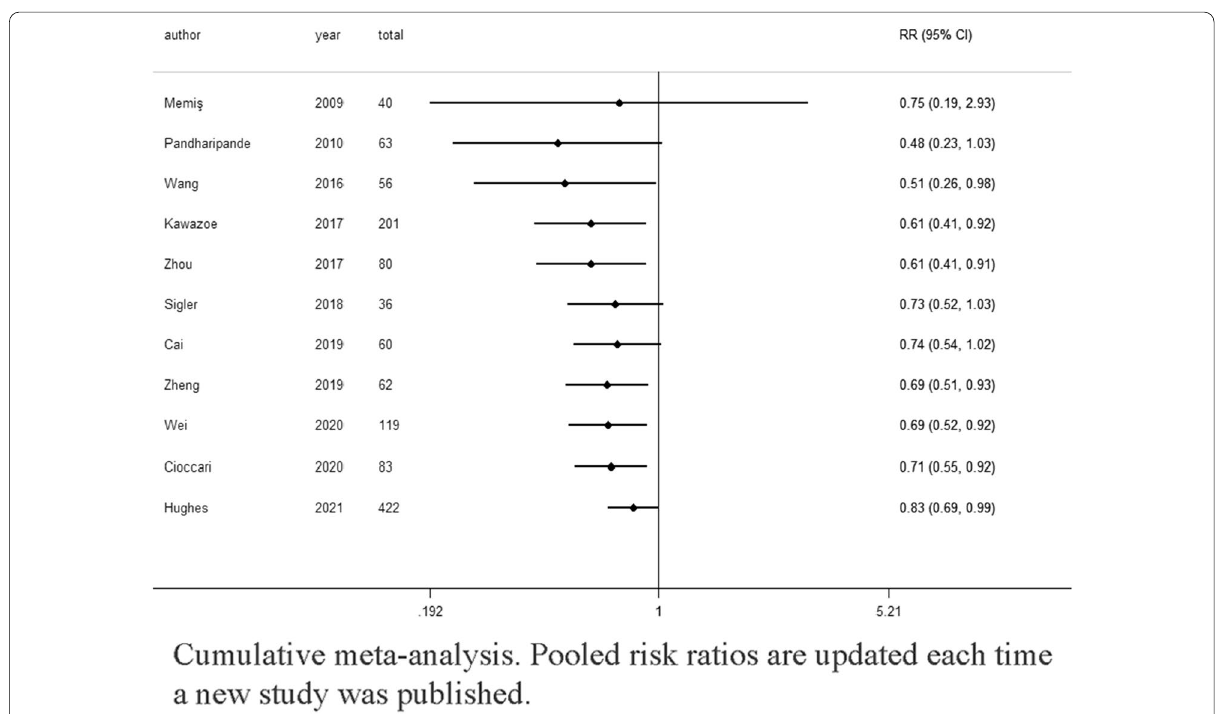
Fig. 5 Cumulative meta-analysis. Pooled risk ratios are updated each time a new study was